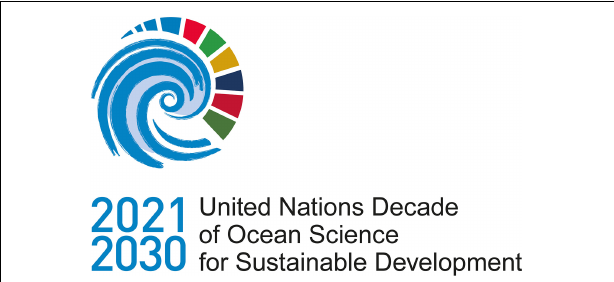
FIGURE 1 | Decade of Ocean Science for Sustainable Development logo. Guidelines to request the logo and obtain permission to use it are available on the Decade website